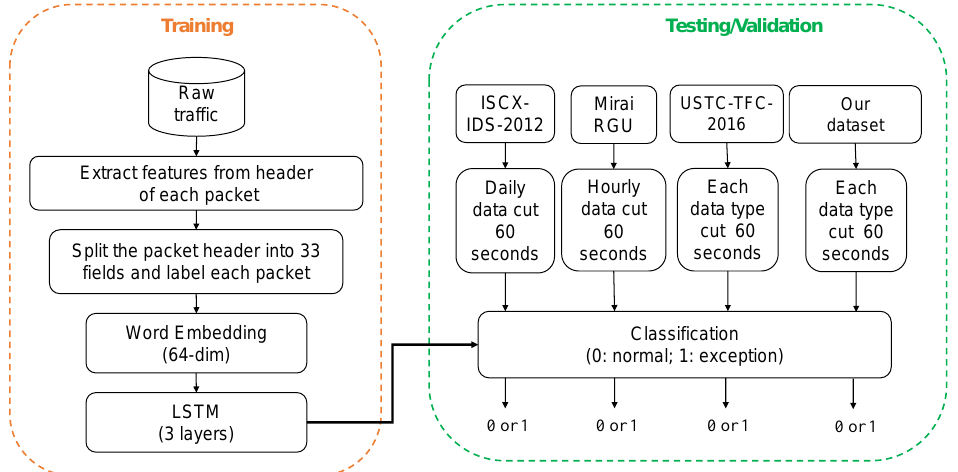
Figure 5. The illustration of the workflow of the training and testing/validation